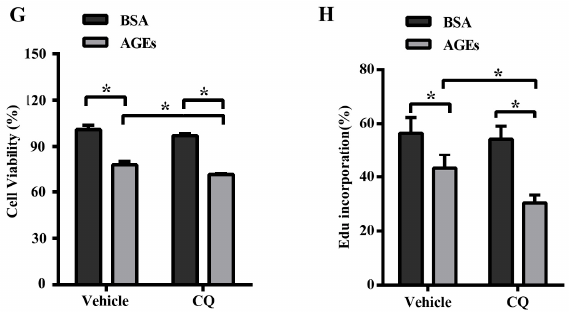
Figure 3. AGEs promoted autophagic flux in HUVECs. Cells were incubated with 10 µM chloroquine (CQ) for 30 min before exposure to 100 µg/mL AGEs and 10 µg/mL BSA for 24 h. ( A ) The protein expression of microtubule-associated protein 1 light chain 3 (LC3)-II/I and p62 were detected using western blotting, and glyceraldehyde 3-phosphate dehydrogenase (GAPDH) served as a control; ( B , C ) The band intensity was quantified using Image J 1.47, normalized by GAPDH; ( D ) After treatment, immunofluorescence was conducted. Cells were stained for p62 (red) and the nuclear marker 4 ′ ,6- diamidino-2-phenylindole (DAPI) (blue); ( E ) The fluorescence intensity of p62 was quantified using Image J 1.47. Three microscopic fields were randomly selected; ( F ) Autophagic vacuoles were detected by acridine orange (AO) staining. Red dots represented autophagic vacuoles; ( G ) Cell viability was detected by MTT assay; ( H ) Cell proliferation was detected by EdU assay. Three microscopic fields were randomly selected. EdU incorporation (%) was quantified by Image J 1.47, which was calculated by the formula: EdU incorporation = cells stained by red/(cells stained by red + cells stained by blue) × 100%. All data were obtained from reproducible experiments ( n = 3). * p < 0.05 compared with respective control.